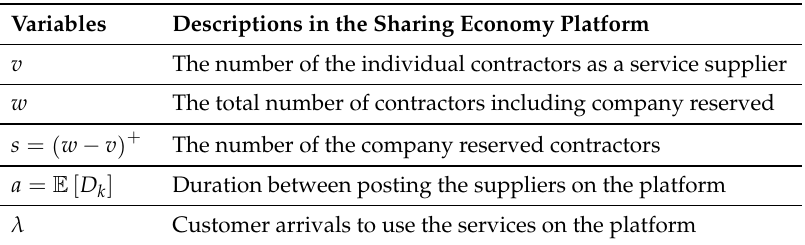
Table 1. Notation